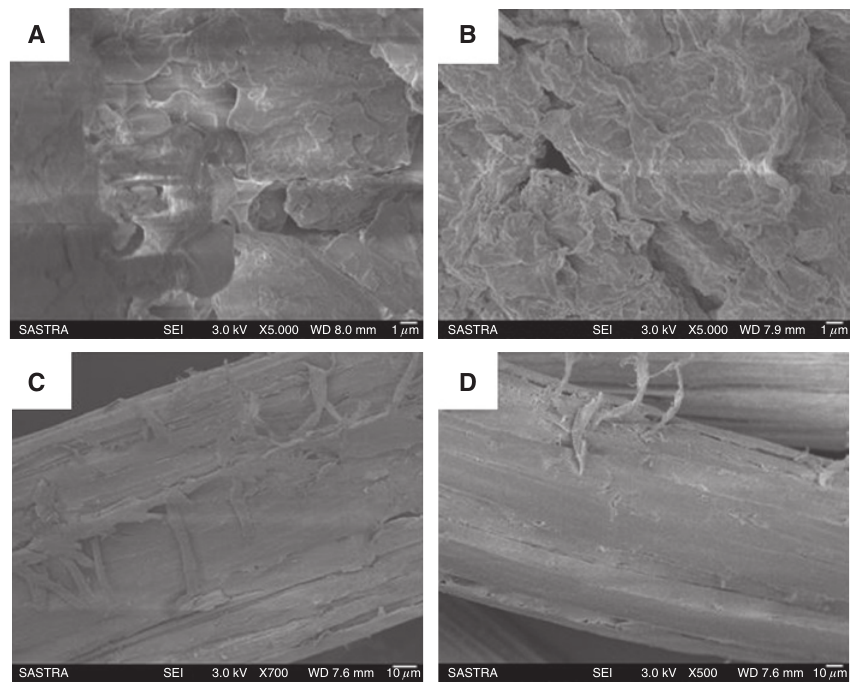
Figure 2 SEM micrograph of (A) raw MSW, (B) treated MSW, (C) raw banana fiber and (D) treated banana fiber.